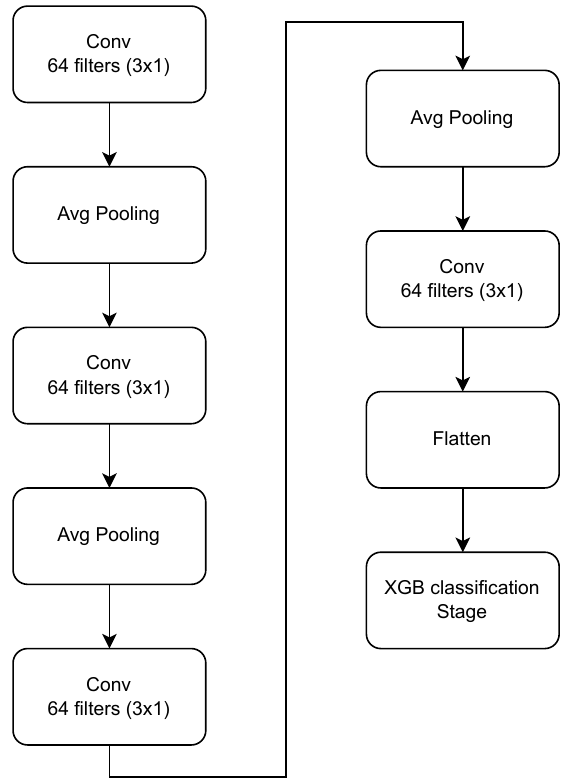
Figure 3. CNN network for feature extraction and XGB classification